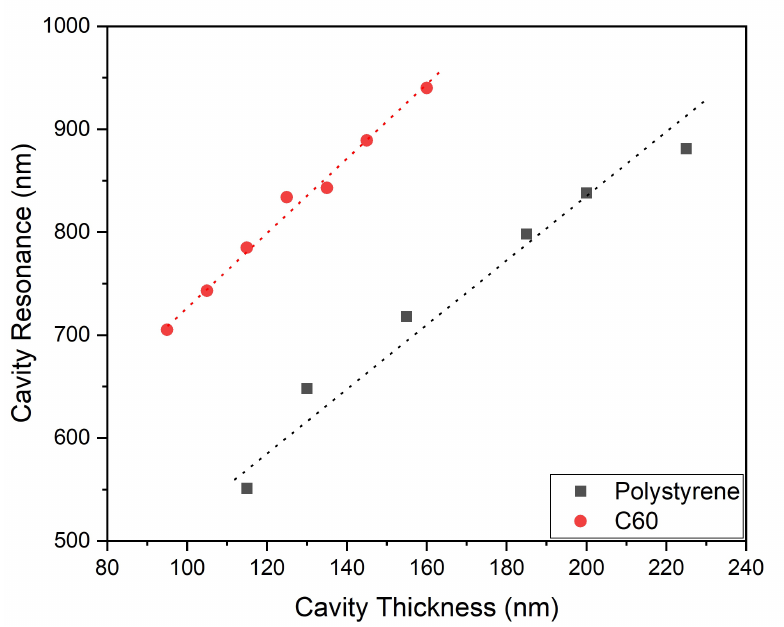
Figure 5. Comparison of cavity resonance with variation of cavity thickness of C 60 and PS